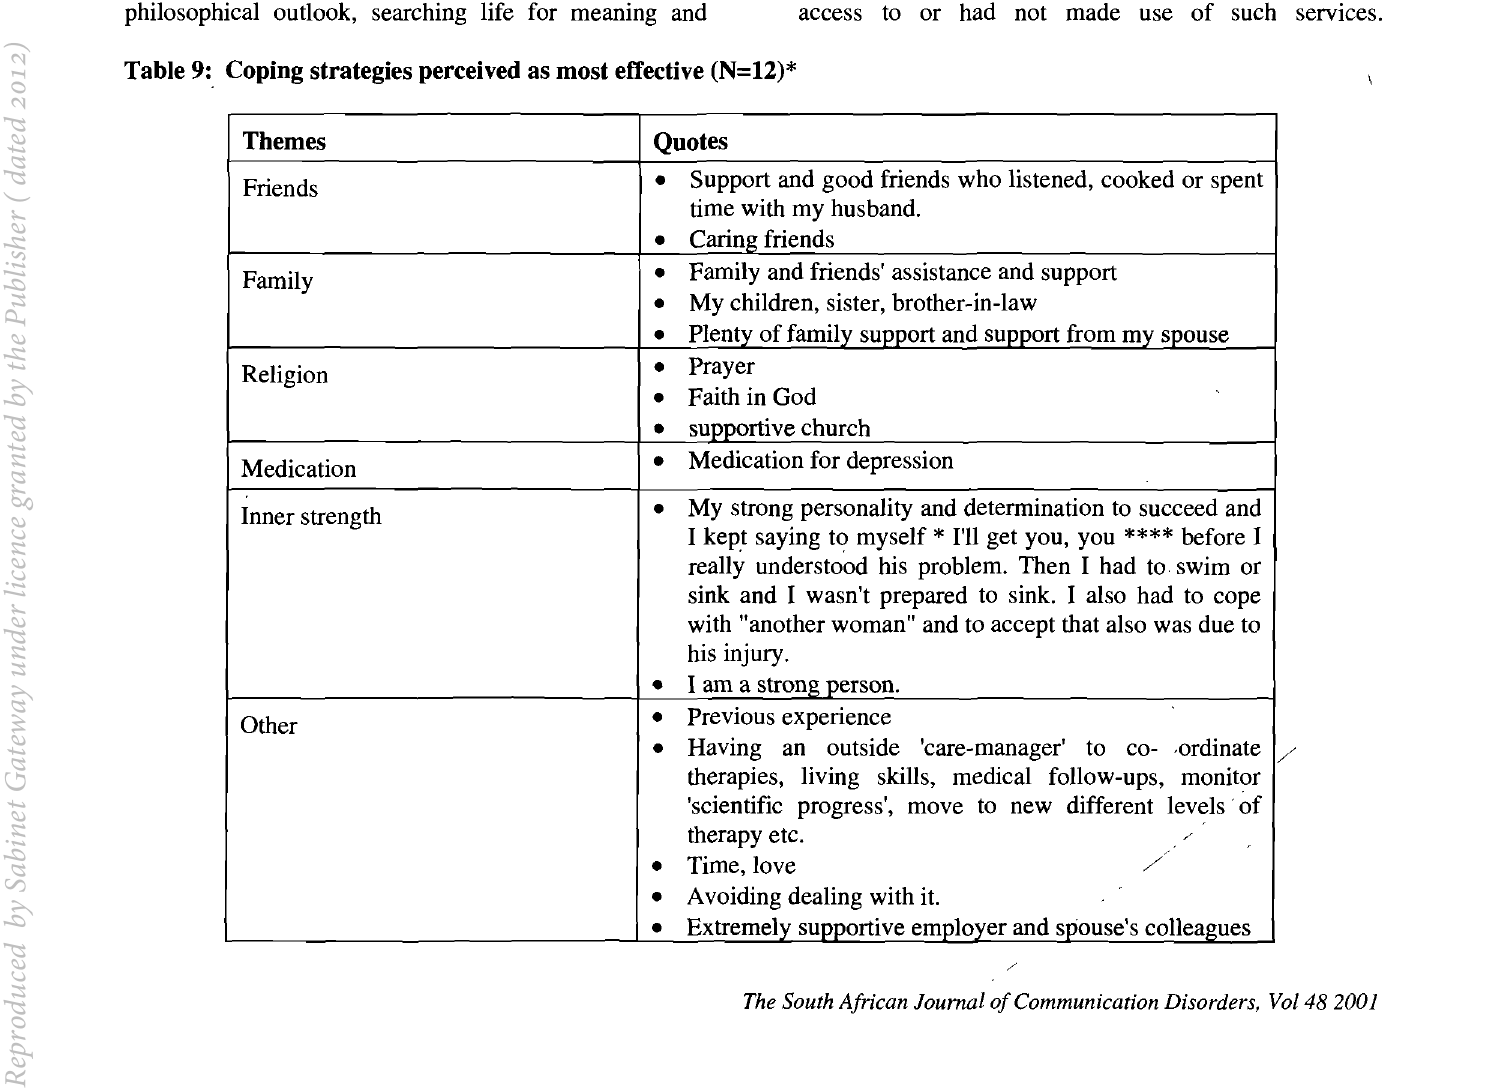
Table 9: Coping strategies perceived as most effective (N=12)*